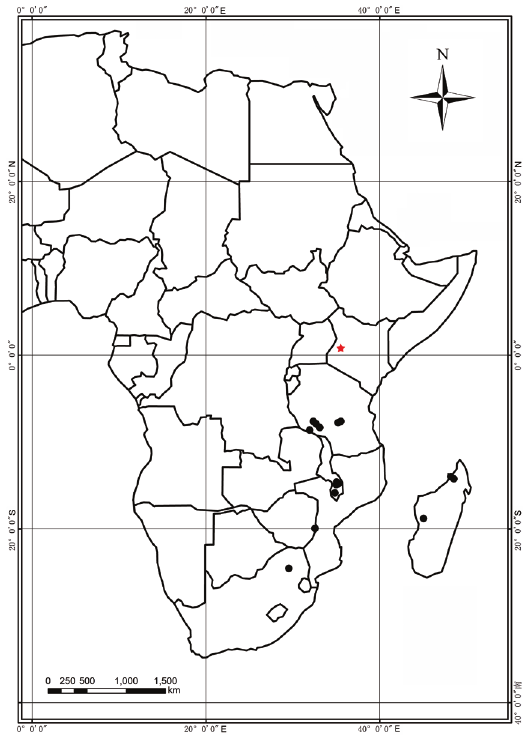
Figure 2. Distribution map of Nervilia lilacea , with the new collection FOKP-1530 shown by a red star [other points re-drawn after Petersson (1990, 1991) and specimen